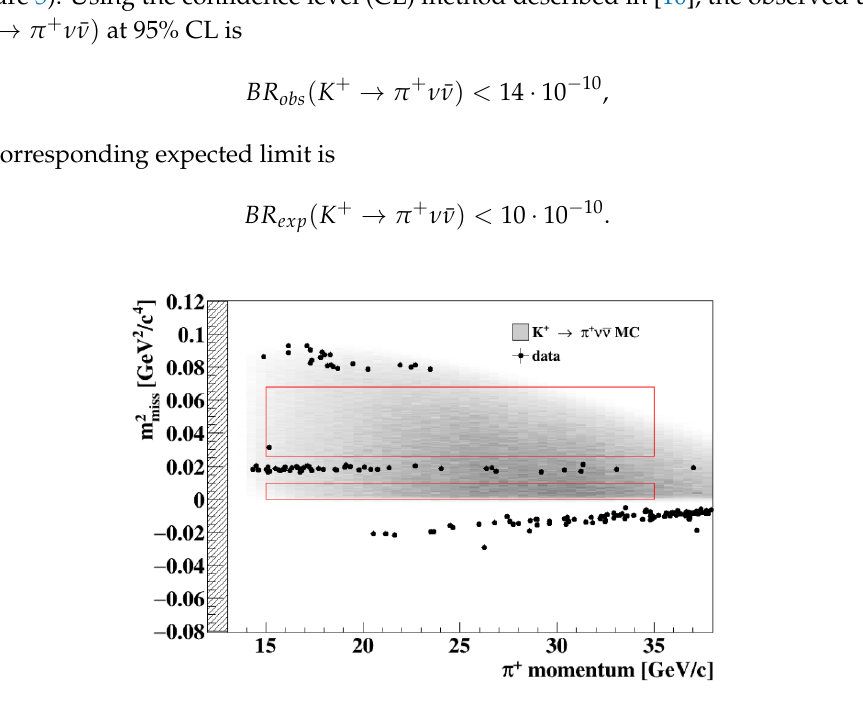
and P π + . The grey area corresponds miss